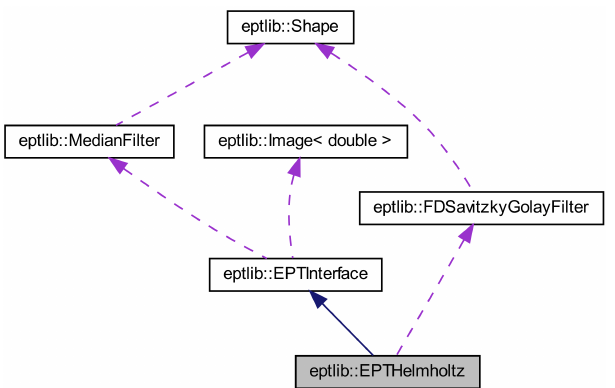
Figure 2. The collaboration diagram of the class implementing Helmholtz-electric properties tomog- raphy (EPT). The dark blue arrow denotes a public inheritance, whilst the purple arrow denotes a collaboration. The classes implementing convection-reaction-EPT and gradient-EPT have an identical collaboration